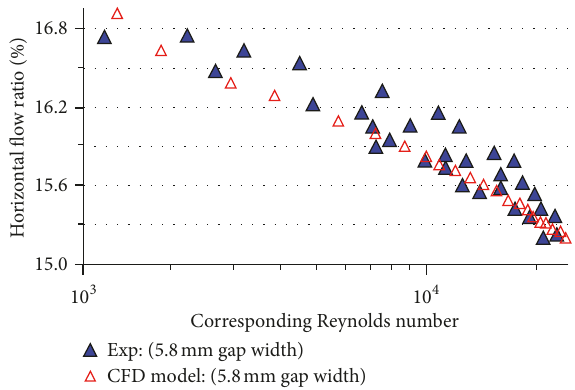
Figure 10: CFD model versus empirical results (5.8 mm).